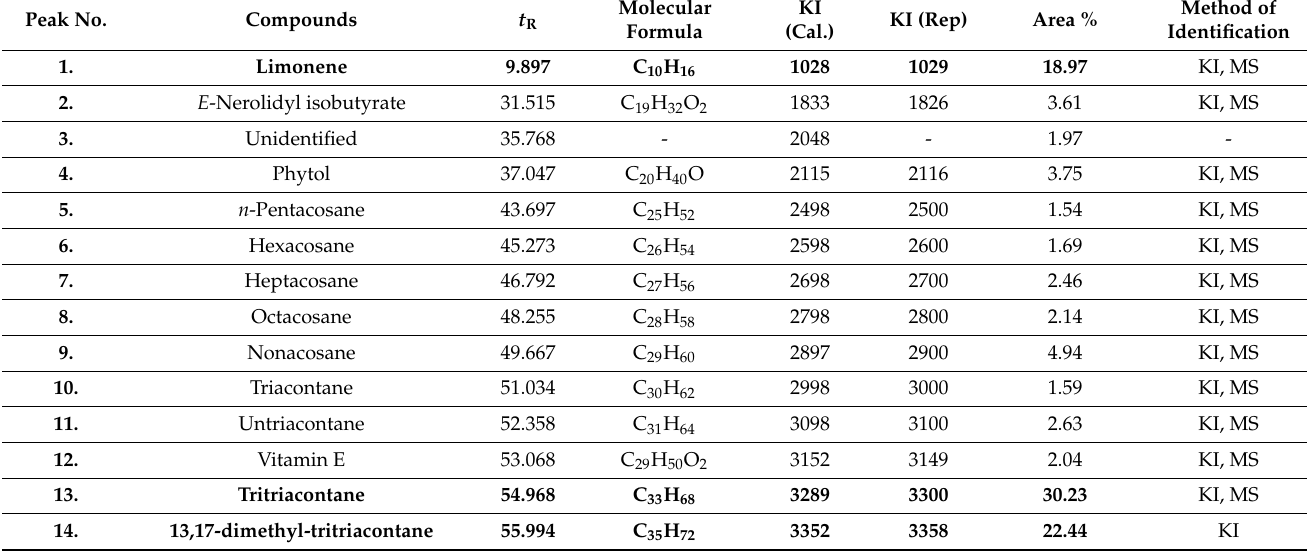
Table 1. GC–MS analysis of Annona glabra hexane